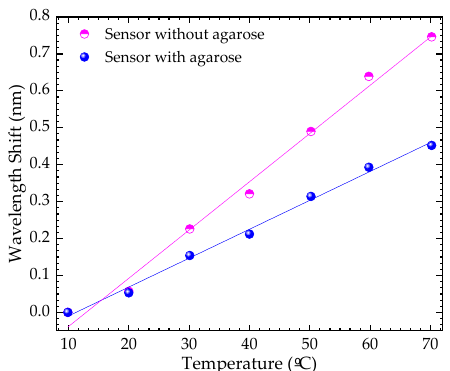
Figure 7. Response of the uncoated and coated sensors to the temperature variations.